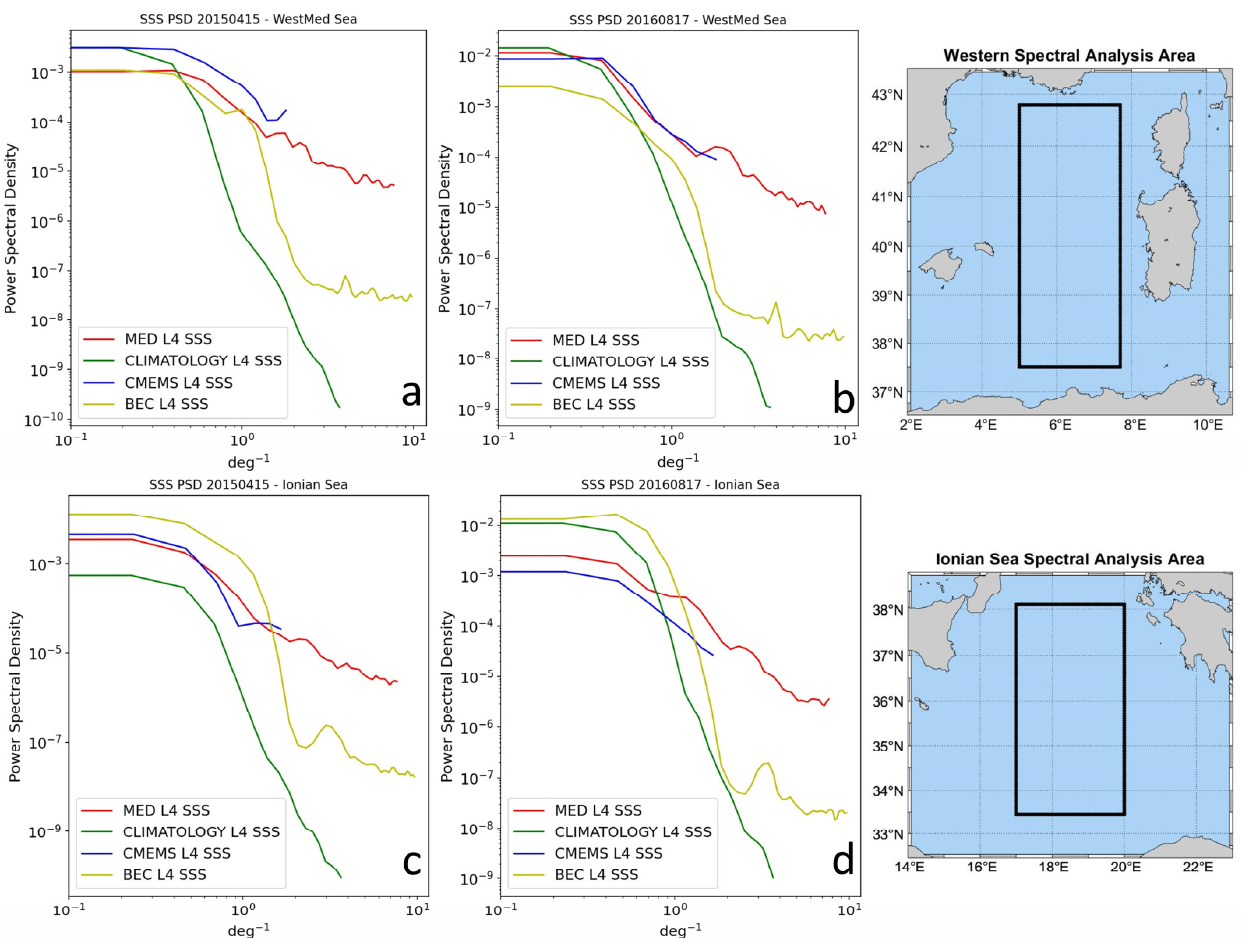
Figure 7. Spatial power spectral density computed from all L4 SSS products ( a – d ) in two different boxes (western Mediterranean Sea, top panel, and Ionian Sea, bottom panel) and dates (4 April 2015 on the right and 17 Aug 2016 on the left ).